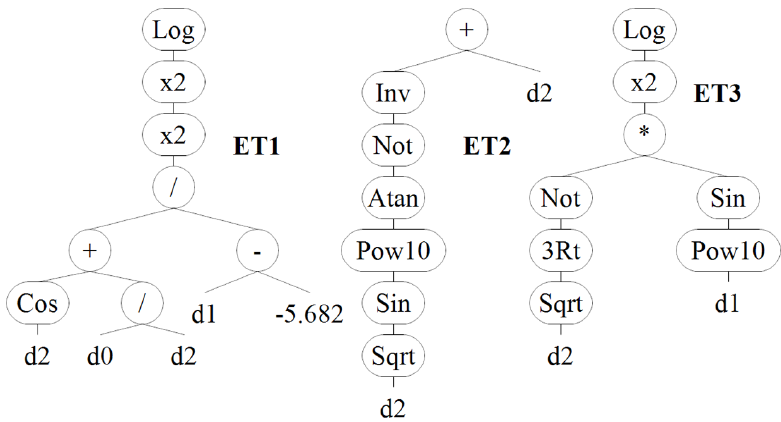
Figure 7. The ETs expression of selected optimum GEP